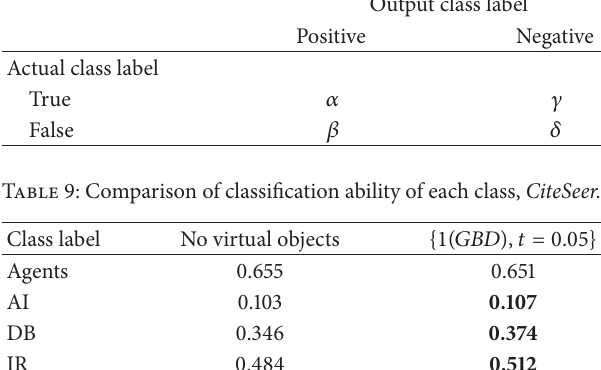
Table 6: Comparison of recognition rates with and without virtual objects ( Cora -training).